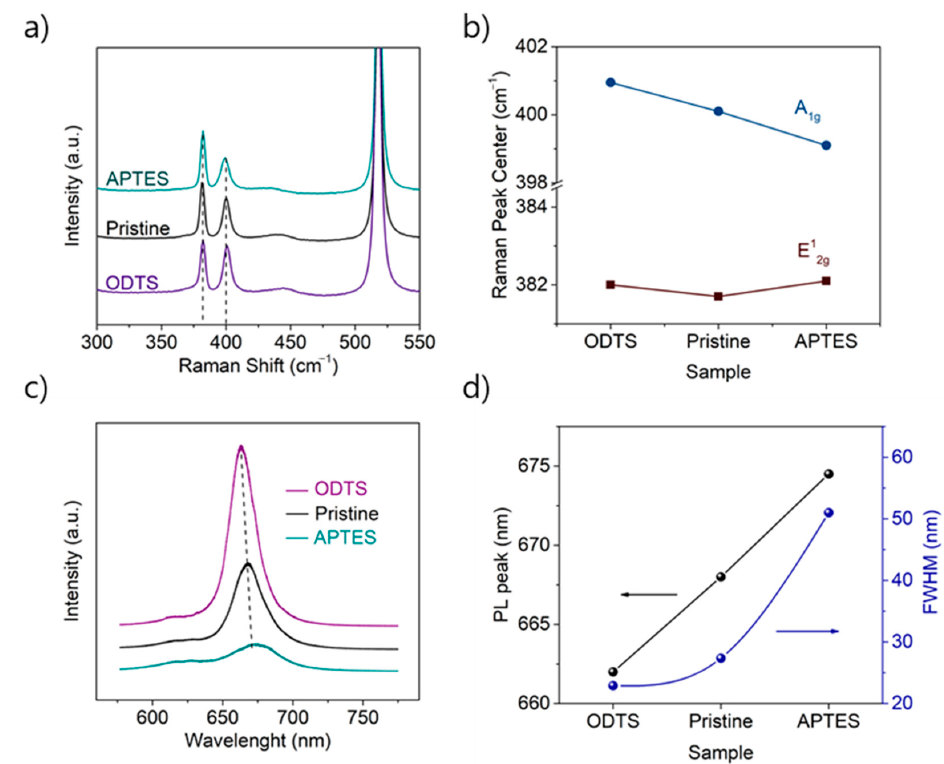
Figure 2. Raman and photoluminesence characterization of MoS 2 monolayer functionalized with ODTS and APTES. ( a ) Raman and ( c ) PL spectra taken from pristine and surface functionalized MoS 2 . ( b ) Raman peak (E12g mode and A1g mode) shift and ( d ) PL peak shift (primary axis) and full width at half maximum (secondary axis) with respect to the functionalized molecules.